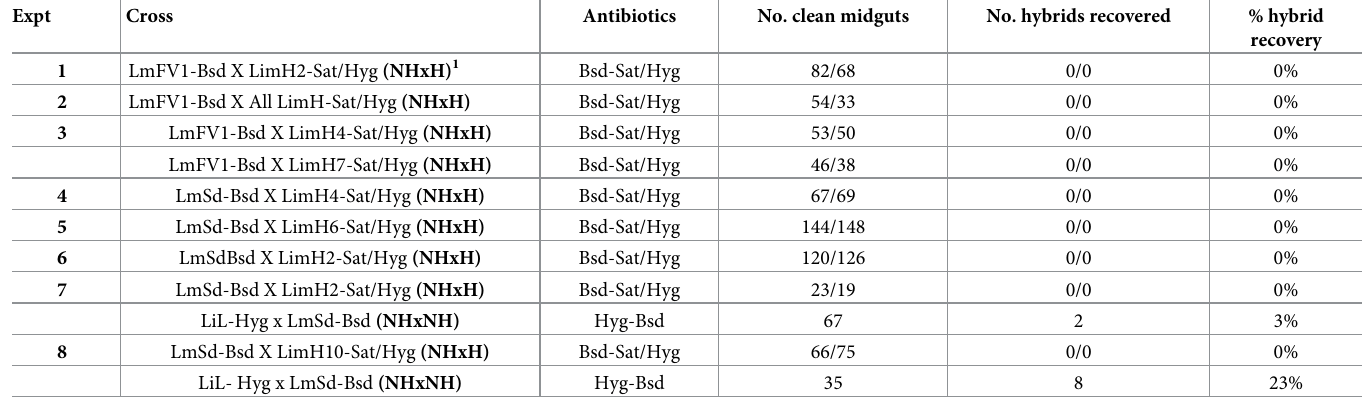
Table 4. Backcross/Outcross matings in Lu . longipalpis involving interspecies F1